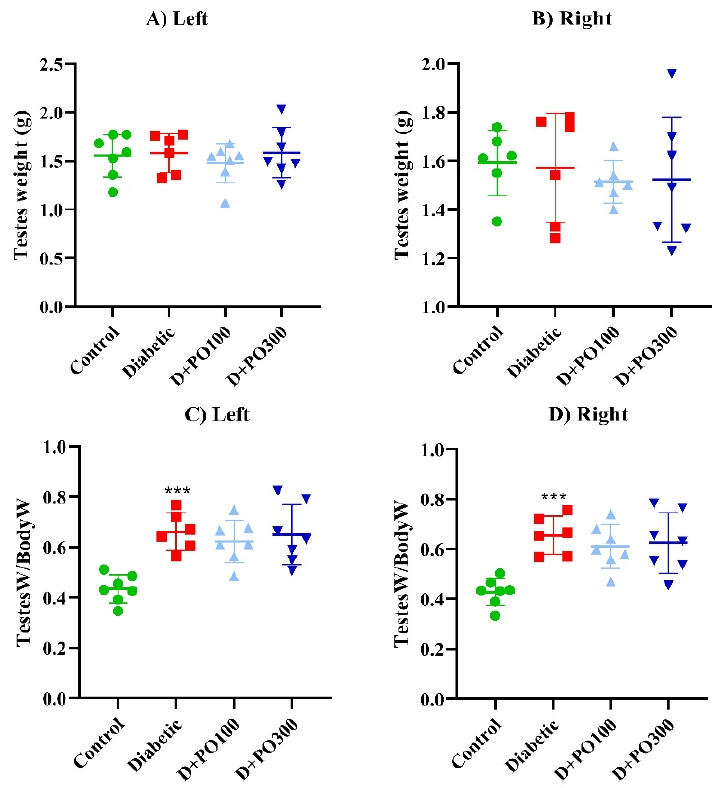
Figure 5. The effects of PO extract on ( A ) left and ( B ) right testicular weight and ( C ) left and ( D ) right testicular/body weight in diabetic rats. The data are presented as mean ± SD. A one-way ANOVA test was carried out with the following Tukey–Kramer’s post hoc test; *** p < 0.001 vs. control group.